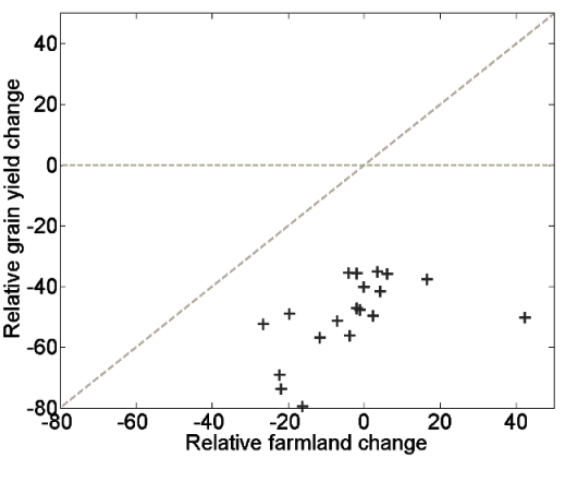
Figure 7. Relationship between relative change in grain yield and relative change in farmland